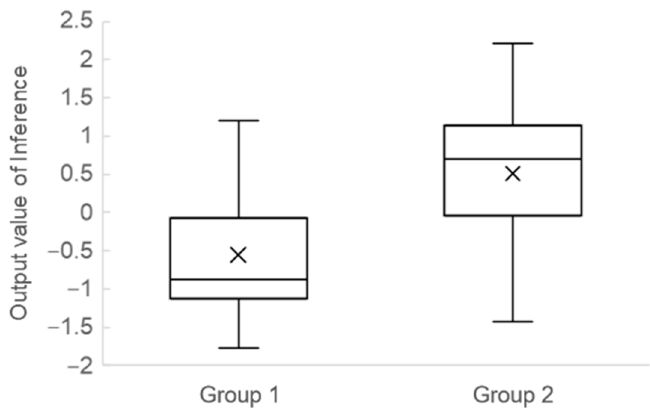
Figure 2. Distribution of the predictive score of the decision tree.